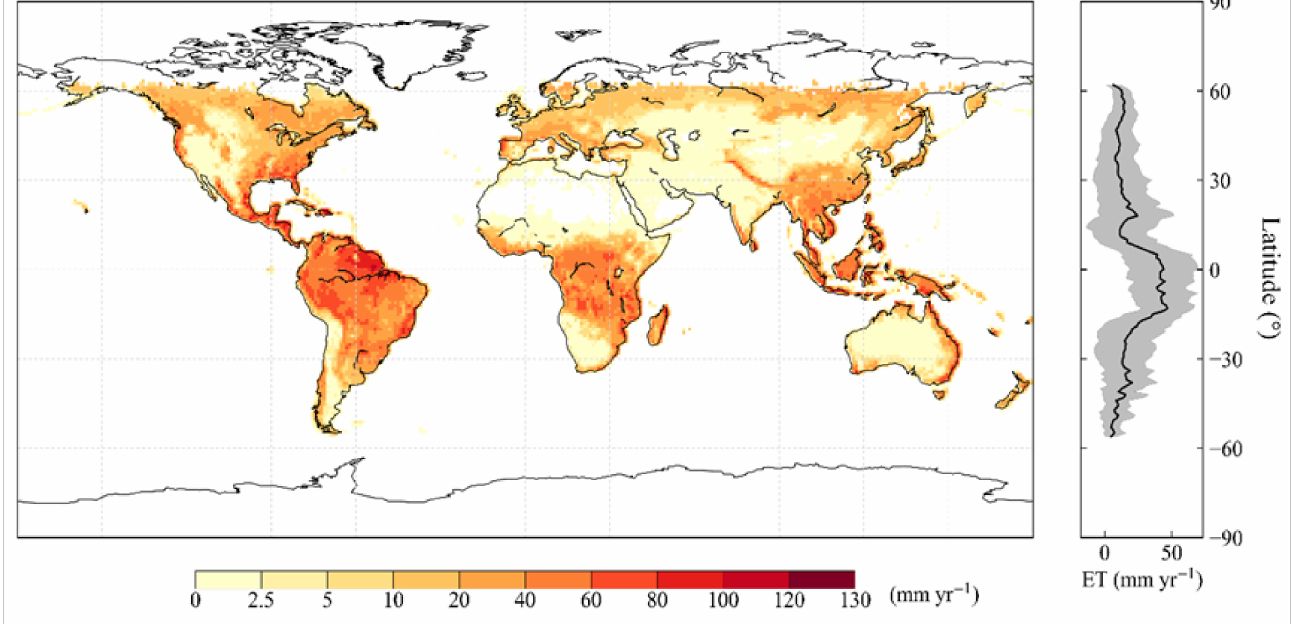
Figure 6. The spatial distribution of bias errors in global terrestrial ET estimates for Case II.